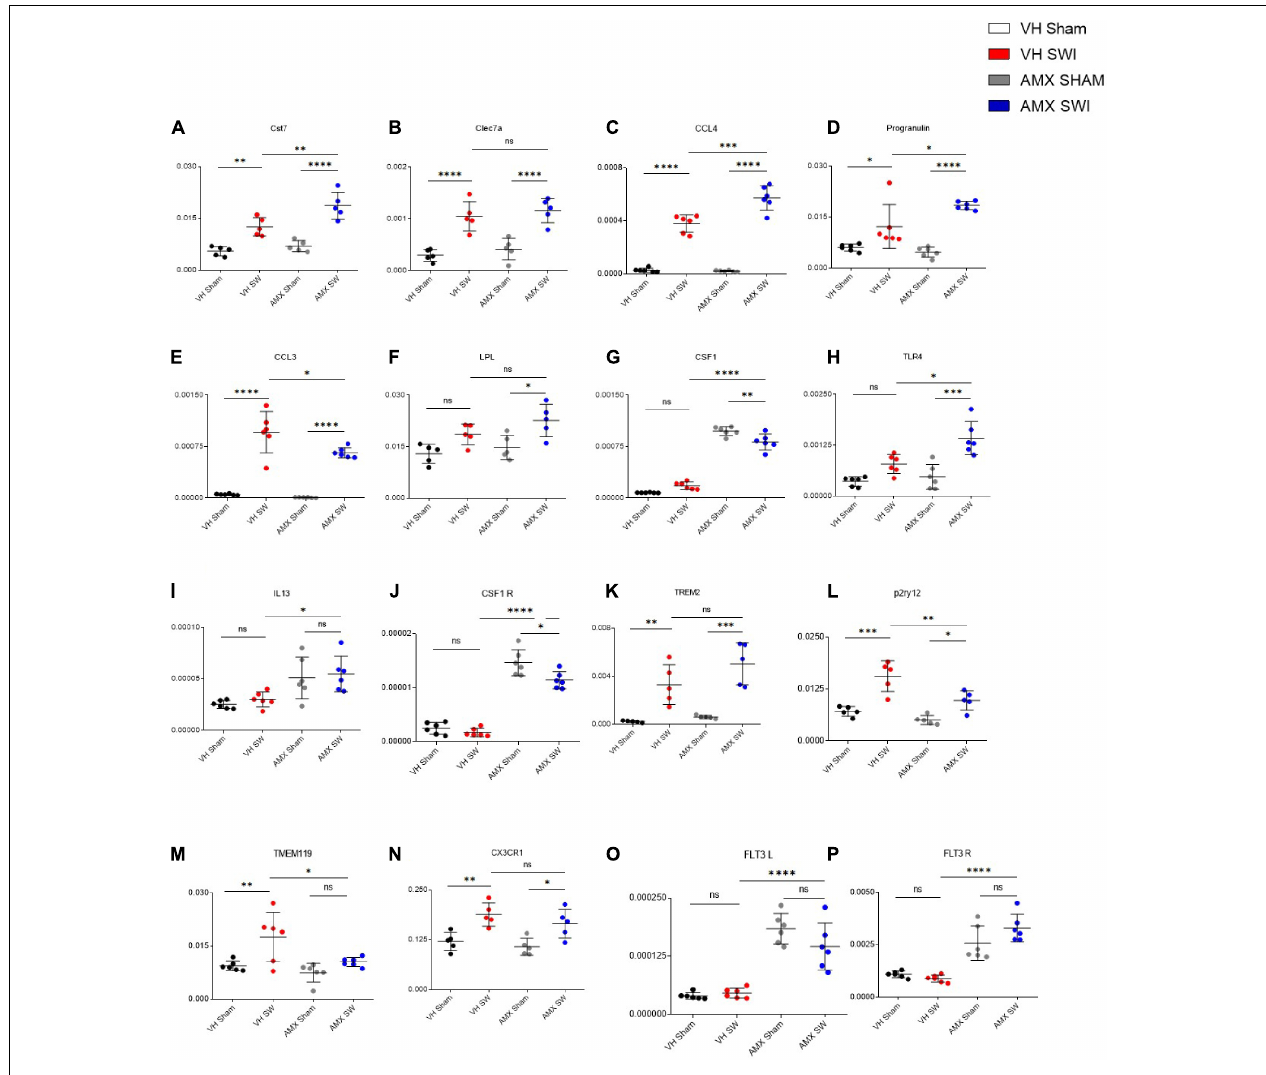
FIGURE 5 | Tbk1 blockade enhances the expression of genes associated with the Disease Associated Microglia (DAM) microglial phenotype after SWI. qPCR from whole-biopsy homogenates were obtained from the injury site (or the corresponding anatomical location in sham mice) from animals treated with either vehicle or AMX at 7 dpi. Among the DAM signature genes, upon SWI, AMX upregulated the expression of Cst7 (A) , CCL4 (C) , Progranulin (D) , CCL3 (E) , CSF1 (G) , TLR4 (H) , and IL-13 (I) . Among the genes characteristically downregulated in DAM, AMX substantially reduced the expression of P2ry12 (L) and TMEM119 (M) . Notably, AMX alone, with or without SWI, upregulated the expression of CSF1 (G) , CSF1R (J) , Flt3 (O) and Flt3R (P) . No difference in expression levels was observed upon SWI with or without inhibitor treatment in Clec7a (B) , LPL (F) , TREM2 (K) , and CX3CR1 (N) . ( n = 3 animals/group with 4 sections/animal. Average ± SD, plus individual data points indicated; one-way ANOVA with Tukey post hoc; ns: not significant, ∗ p < 0.05, ∗∗ p < 0.01, ∗∗∗ p < 0.001, ∗∗∗∗ p < 0.0001; full statistical report in Supplementary Table 7 ).